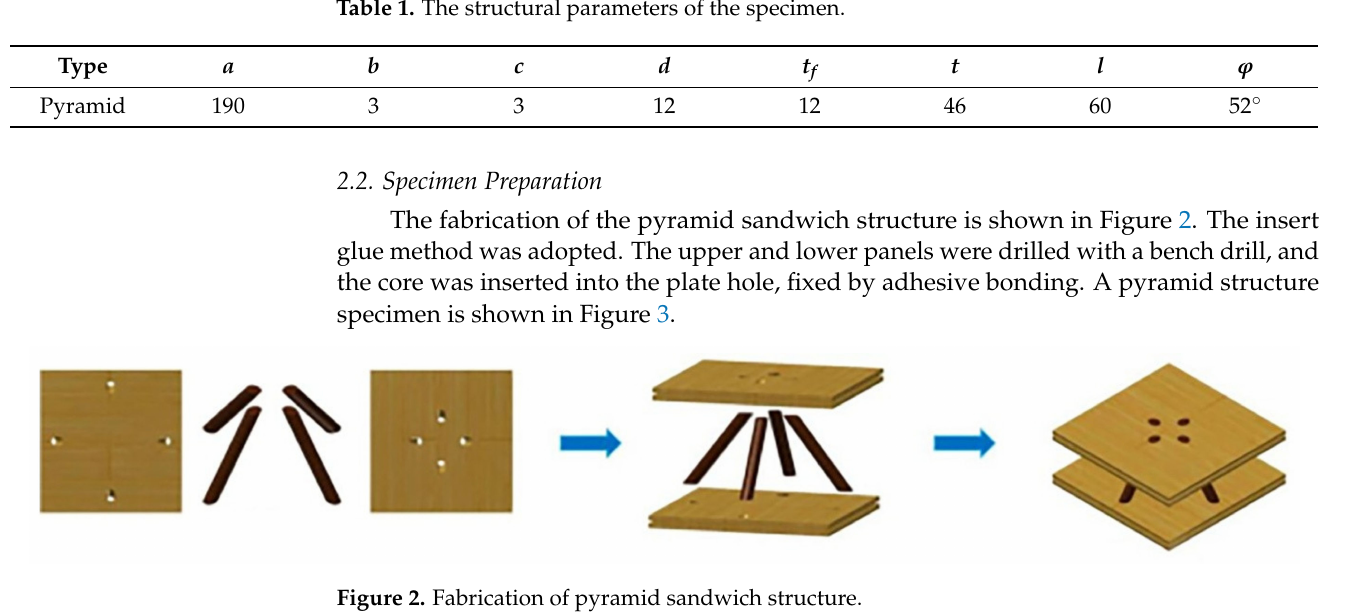
Figure 2. Fabrication of pyramid sandwich structure.